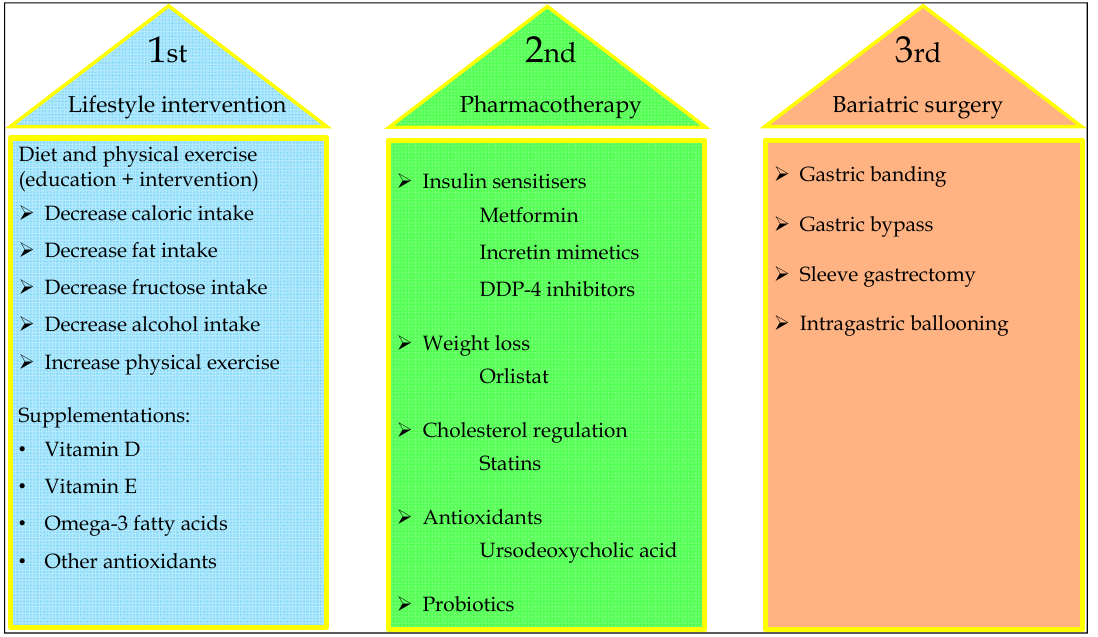
Figure 3. Management of paediatric NAFLD.